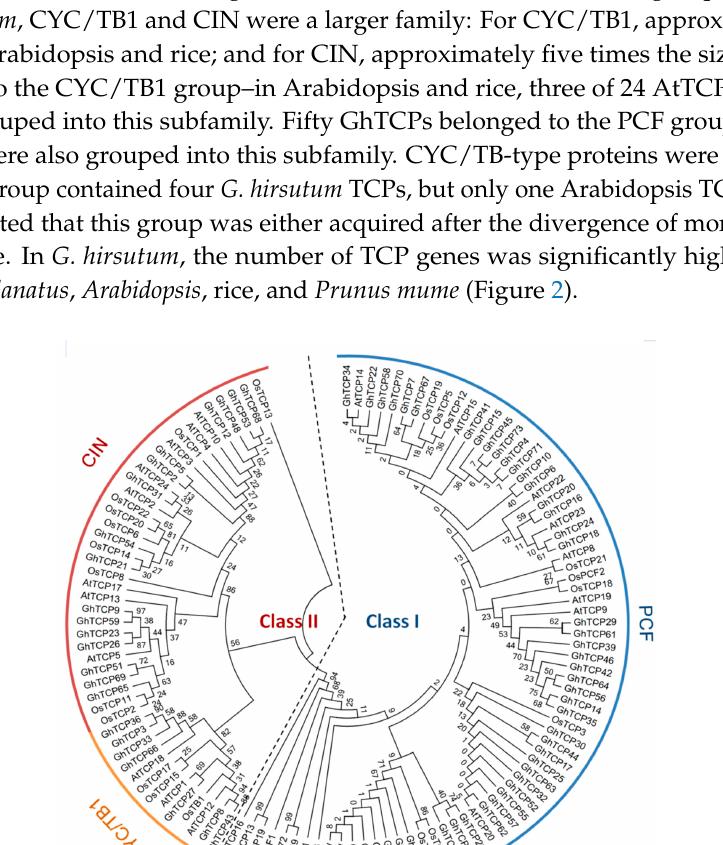
Figure 2. TCP family members of G. hirsutum , G. raimondii , G. arboretum , tomato, Citrullus lanatus , Arabidopsis, rice, and Prunus mume. Different colors represent the different subclasses,and the number of genes in each subclass is shown. Green: CYC/TB1 genes; Red: CIN genes; Blue: PCF genes. 2.2. Genomic Distribution, Gene Structural Organization,and Domain Analysis of GhTCP Genes